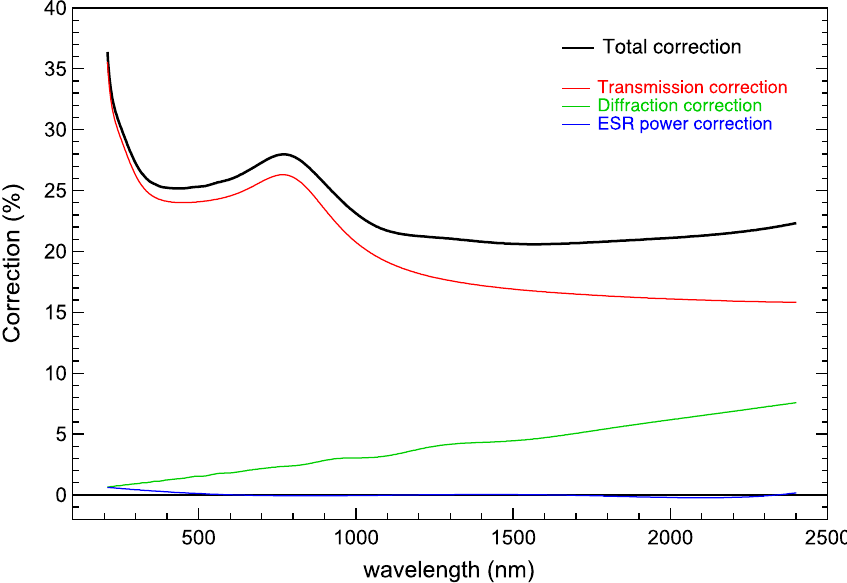
Figure 11. Plot of the measurement equation spectrally dependent corrections. These represent the known “photon-loss” factors that must be accounted for in deriving the true SSI from the measured detected power at the ESR (see text).